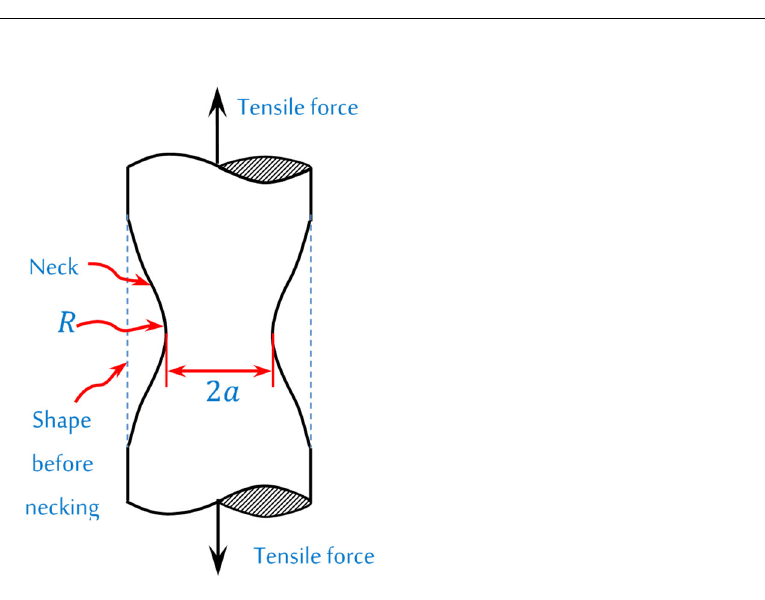
Figure 8. Necking of reinforcing steel rebar specimens under tension.